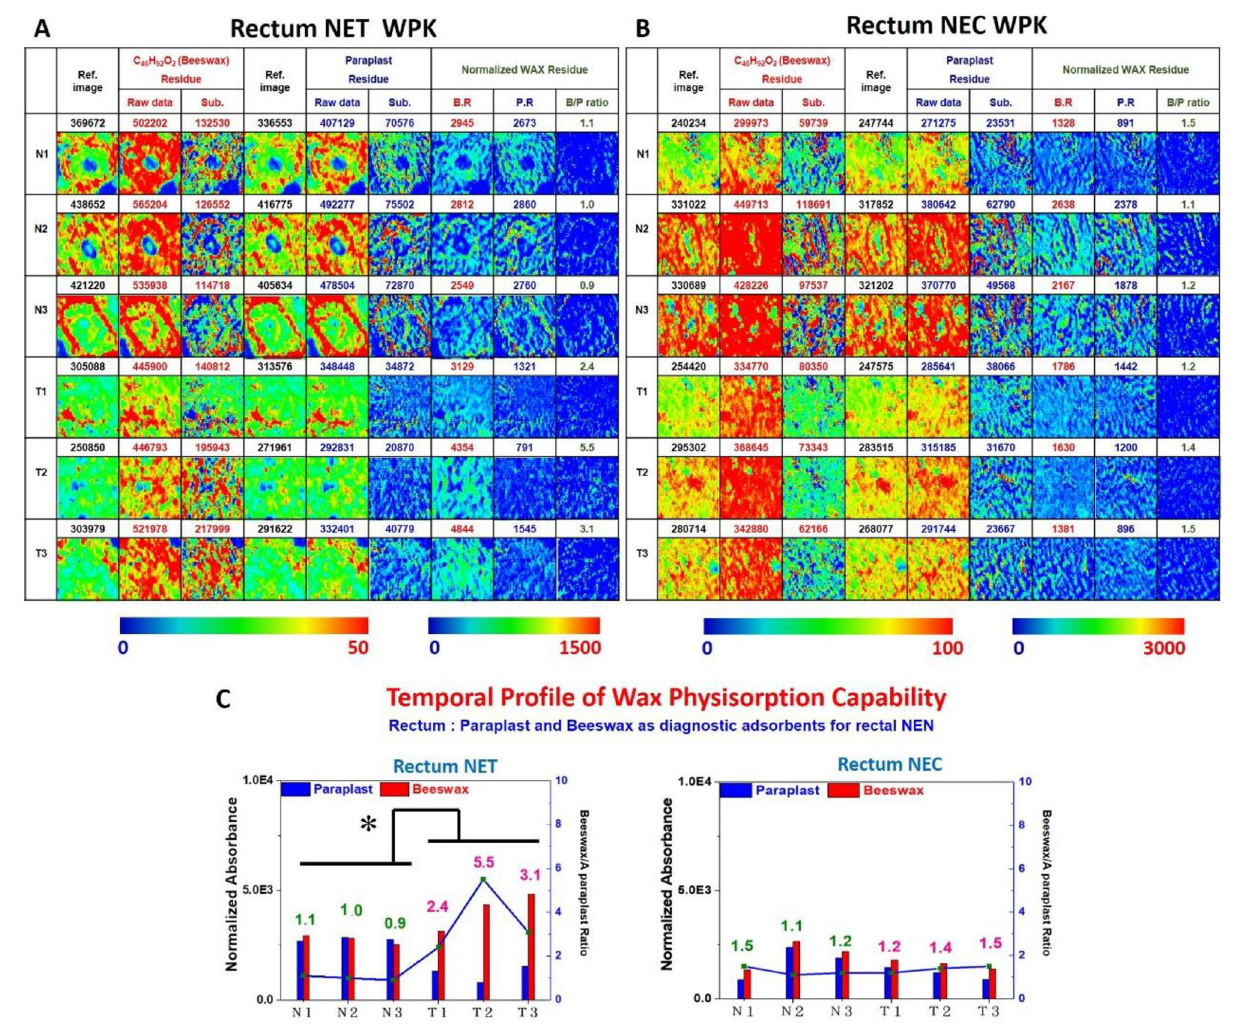
Figure 3. ( A , B ) The WPK-FTIR images present the distribution of remnants of beeswax and paraplast wax adhering to the surface of rectal tissue in NET and NEC. (Ref. Image: reference image before waxing, Raw data: the IR absorbance data after waxing and dewaxing, Sub: subtract reference data from raw data.) The left column of the images absorbance scale indicates the beeswax and paraplast absorbance before normalizing by the number of carbon atoms. The right column of the absorbance scale indicates the absorbance after normalizing. ( C ) The quantitative results and the ratio of average adsorption levels of wax normalized by the number of carbon atoms on human rectal NENs. (X axes: each three representative interest areas of adjacent normal mucosa (N) or tumor area (T); left Y axes: average adsorption levels of beeswax and paraplast wax; right Y axes and the number over the histograms: the ratio of beeswax /paraplast wax.) There was a significantly higher IR absorbance ratio of beeswax-remnant to paraplast- remnant between malignant and adjacent benign areas in rectal NET G1 (*p =